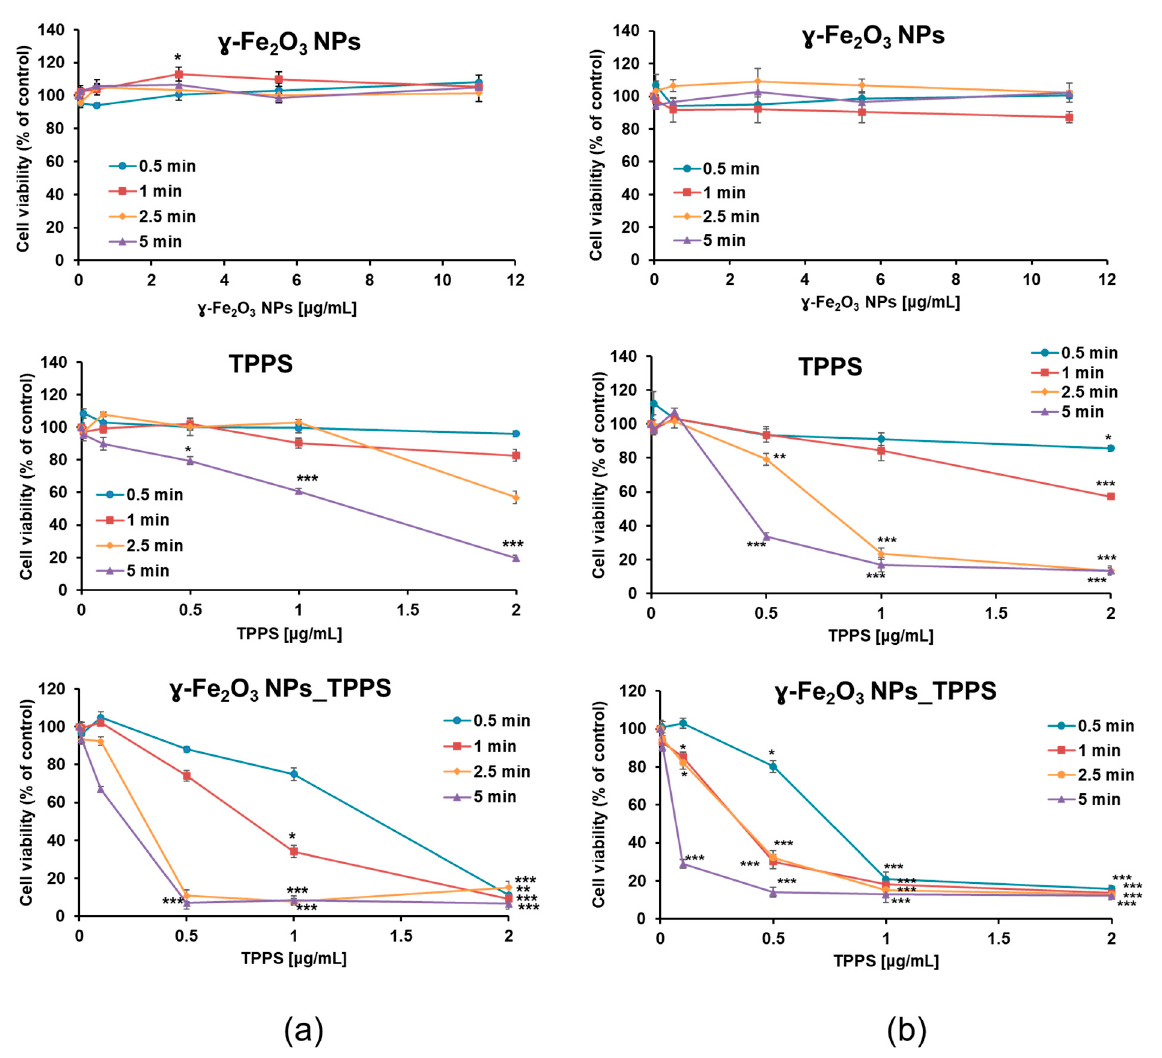
Figure 11. Variation of Mell-Juso cell viability depending on irradiation time (min), led power density (mW/cm 2 ) and treatment dose. Cells were incubated for 24 h with γ -Fe 2 O 3 NPs, TPPS and their complex at different concentrations and then irradiated for 0.5, 1, 2.5 and 5 min at ( a ) 1 and respectively ( b ) 2 mW/cm 2 power densities. After 24 h from irradiation cell viability was evaluated by MTT assay. Data ( n = 3) were expressed as percentages related to control (100%) ± standard deviation (SD). The results were considered statistically significant when * p < 0.05; ** p < 0.01; *** p < 0.001 (sample vs. control).